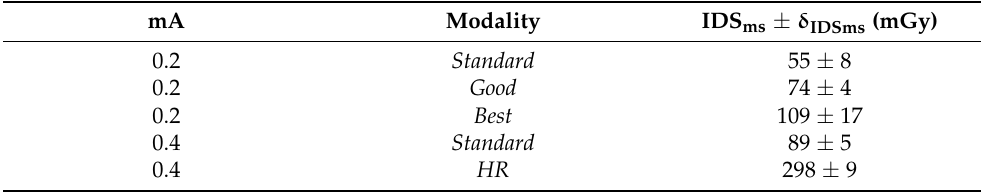
Table 7. Imparted Dose at the Surface of the mice (IDS ms ) at the 45 kV potential of the X-ray tube.